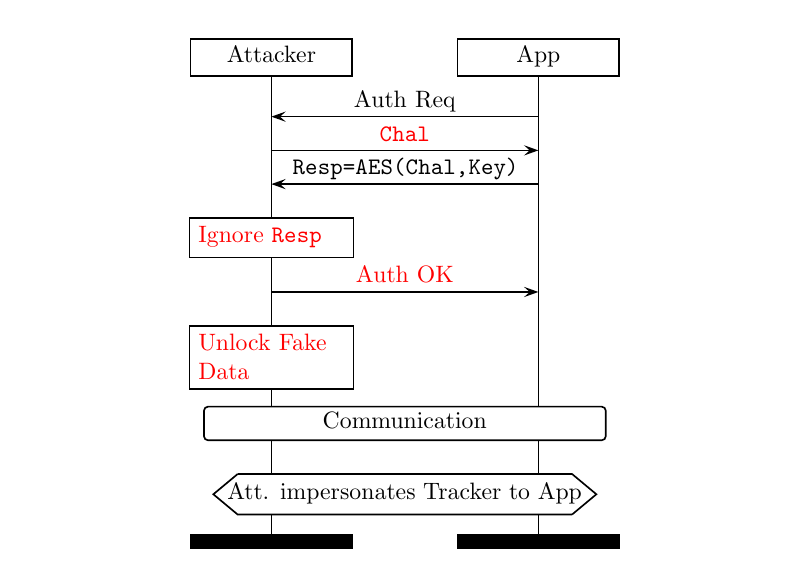
Figure 6: OTA tracker impersonation attack. The attacker impersonates a tracker by spoofing the tracker’s BLE address and BLE advertisement packets. The victim (Mi Fit or Zepp app), which is already paired with the impersonated tracker, recognizes the attacker as trusted and sends her an authentication request (Auth Req). The attacker’s device answers with a random challenge ( Chal ). The app solves it and sends back a response ( Resp ) computed from the pairing key unknown to the attacker. The attacker ignores Resp , answers with a positive authentication message ( Auth OK ), and unlocks its fake GATT server. As a result, the app starts the Communication protocol with the impersonated tracker, believing it is